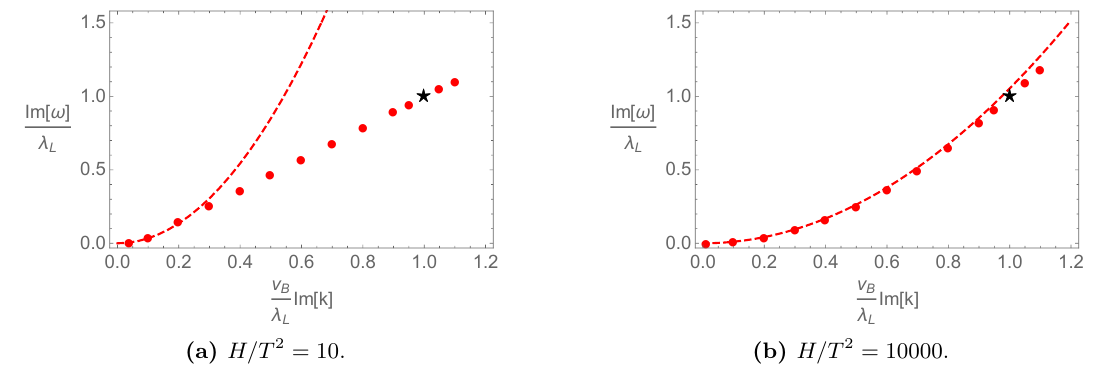
Figure 6. Pole-skipping and diffusive mode at µ/T = 5 . All dots are quasi-normal mode, a dashed line is (2.24), and the star is the pole-skipping point